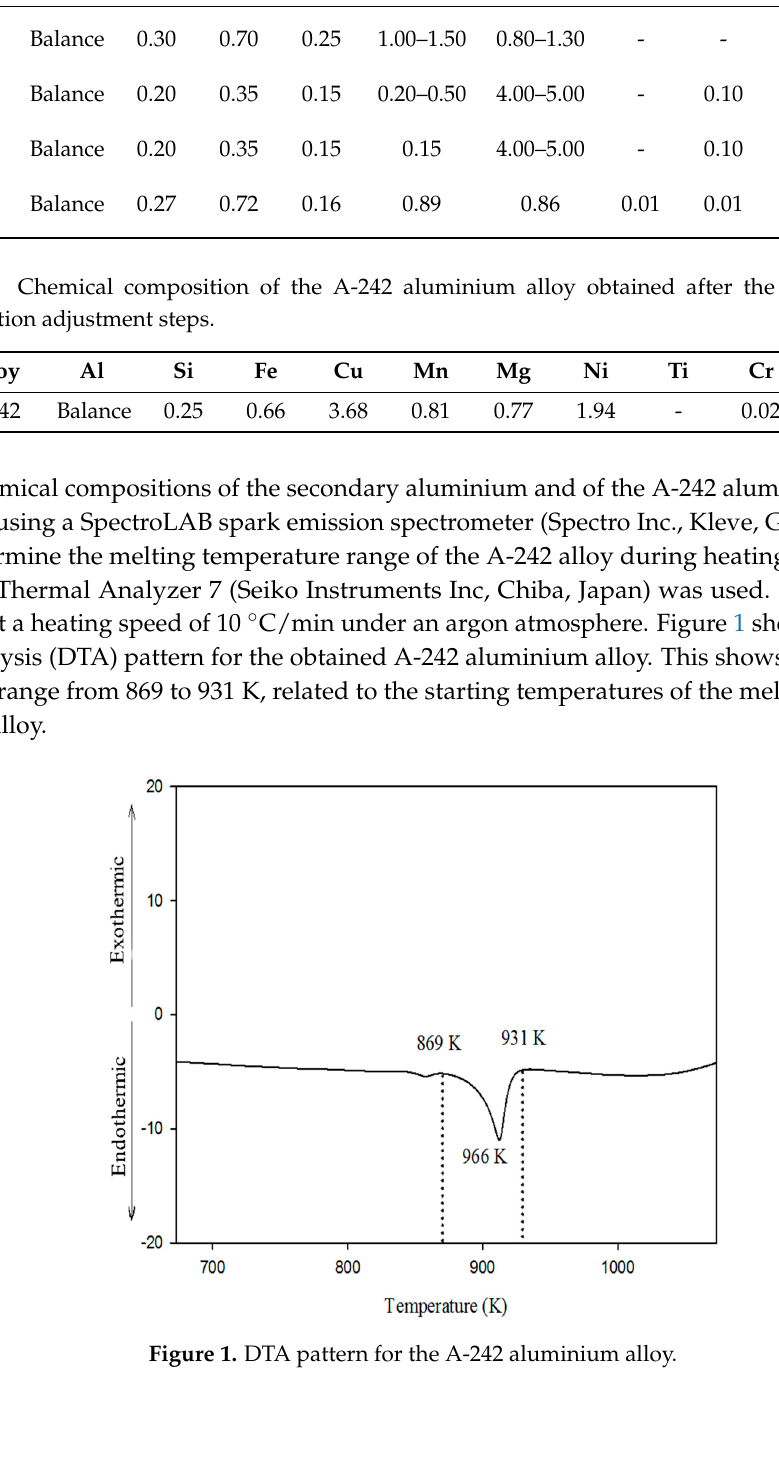
Table 4. Values selected for the preparation of A-242 aluminium alloy foams (foaming time is constant for 30 s).